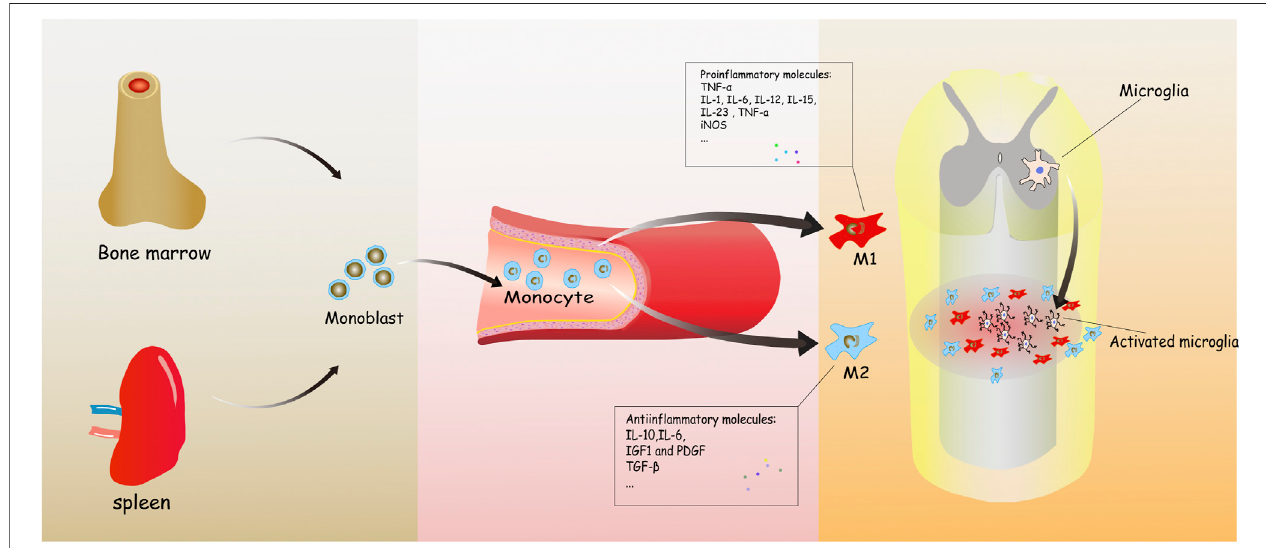
FIGURE1| Itconcisely showsthedevelopmentprocessofthemonocyte-derivedmacrophages frombonemarrowtoinjuredspinalcord.Monoblasts, originfrom the bone marrow, circulate in the blood normally. When in fl ammation happens, various molecules are released to induce and transform hematogenous macrophages into two types, playing mostly different roles in spinal cord injury